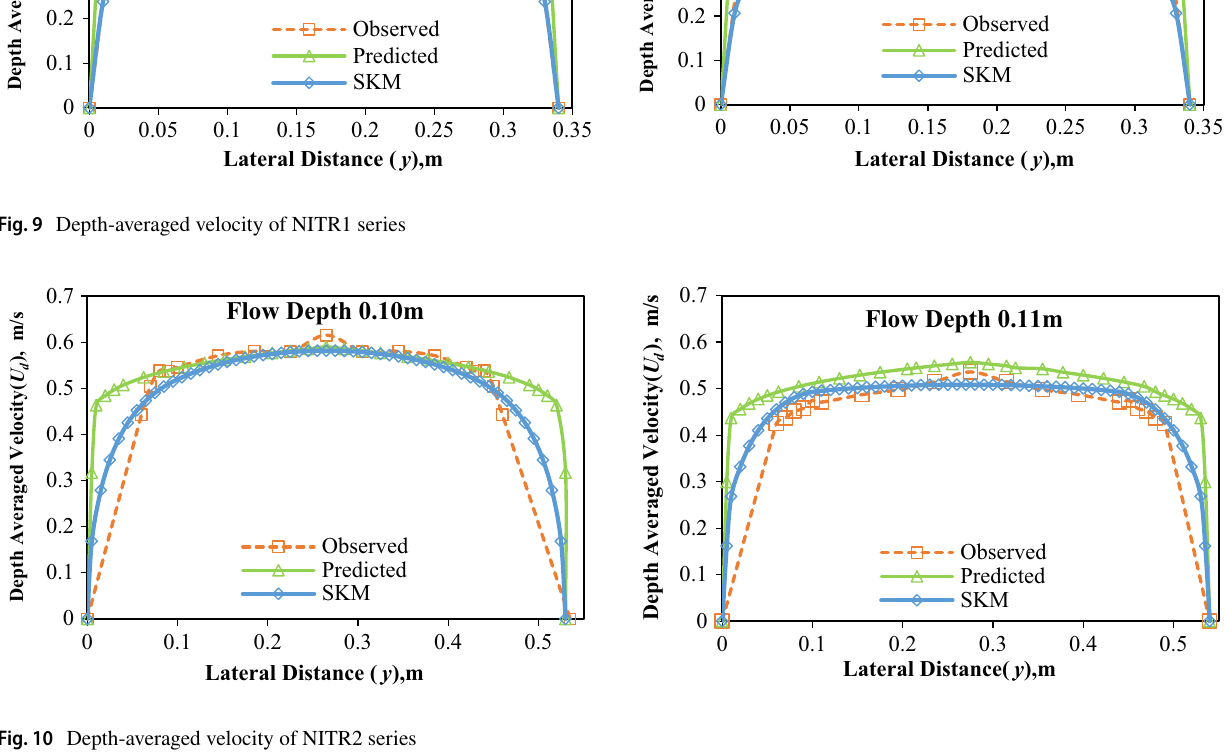
Fig. 10 Depth-averaged velocity of NITR2 series